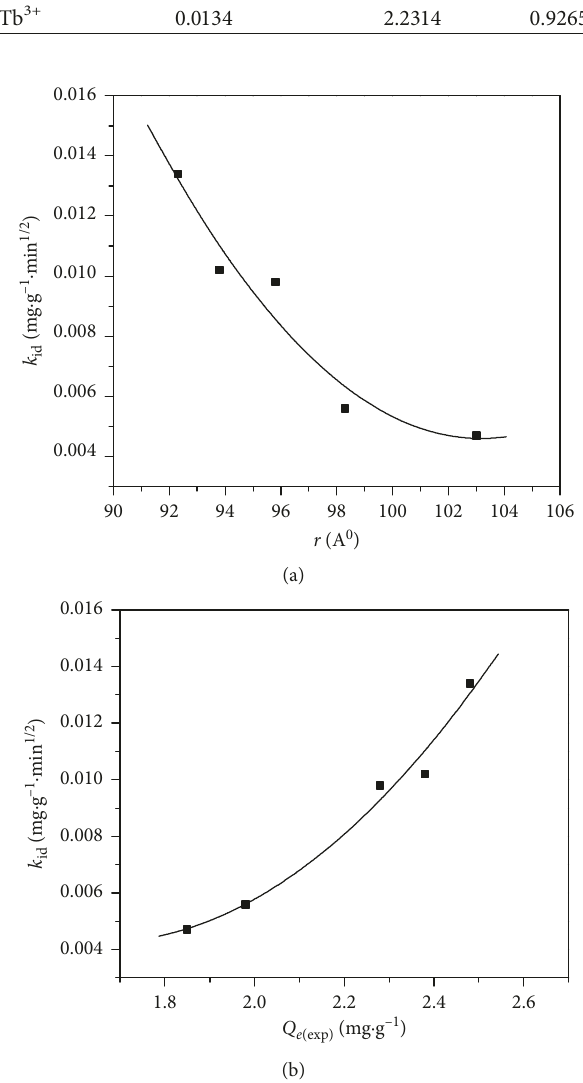
Figure 5: (a) Plot of ionic radius of Ln 3+ versus k of Q e (exp) of Ln 3+ versus k id